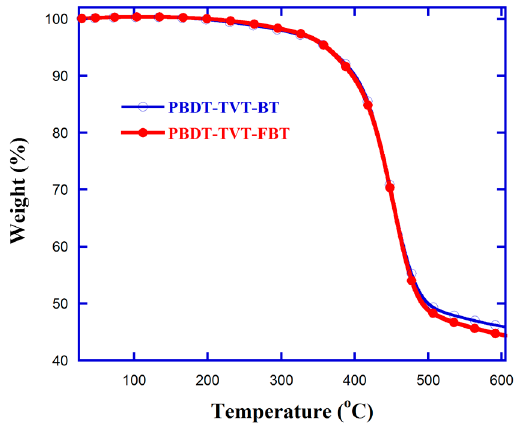
Figure 1. TG curve of the highly conjugated donor–acceptor (D-A) type copolymers PBDT-TVT-BT and PBDT-TVT-FBT.